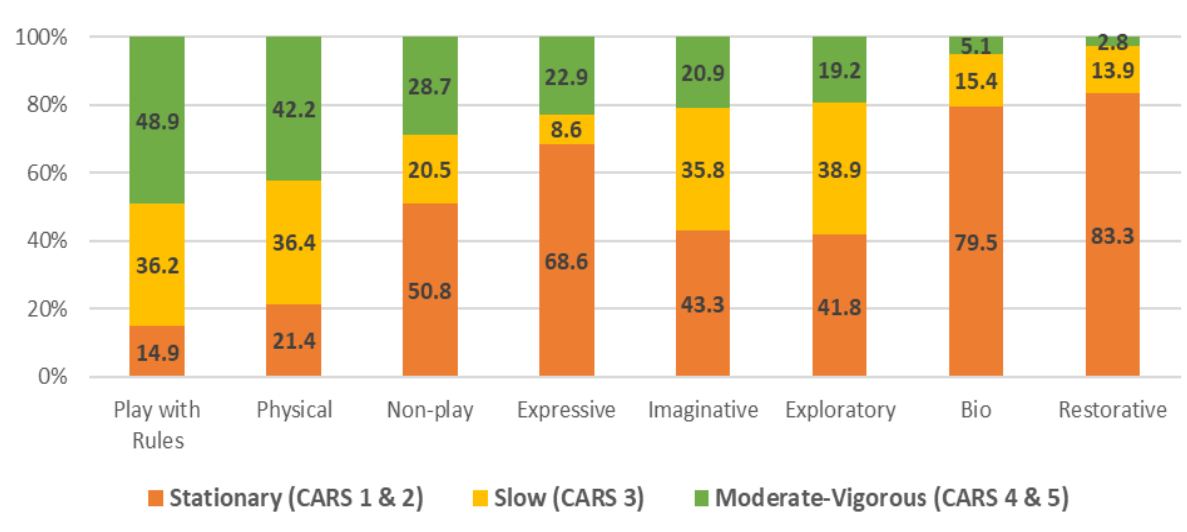
Figure 9. Outdoor play type by activity intensity. Risk-Related Behaviors: Using all of Little’s risk categories, observations indicated that close to half of play activities involve no to very low levels of risk. However, more than half of the play events (52.8%) exhibited characteristics of positive behaviors, particularly low positive risk (34.5%) and moderate positive risk (17.6%); less than 1% were categorized as involving high positive risk (See Table 1; Figure 10). In contrast, very few play events involved any level of negative risk; of 693 play events, only 5 (less than 1%) had elements of negative risk.